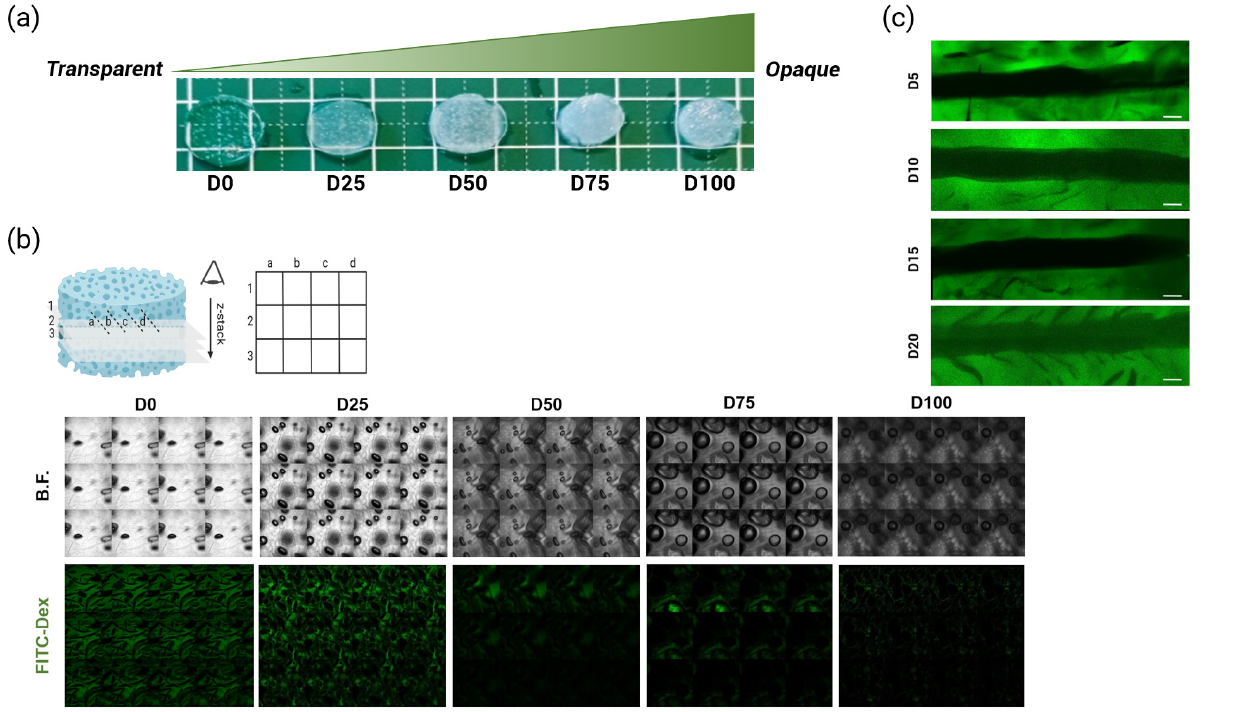
Figure 3. ( a ) Hydrogel opacity increased with an increase in DD concentration; ( b ) Hydrogel opacity as observed using CLSM: under bright-field and fluorescence (FITC). Z-stack images of hydrogels without DD (D0) and with DD 25–100% (DD:Dex w / w ) were compiled as collages to demonstrate the increase in sample opacity with an increase in sample depth. ( c ) Z-projection (average intensity) of FITC-Dex hydrogels observed using CLSM.